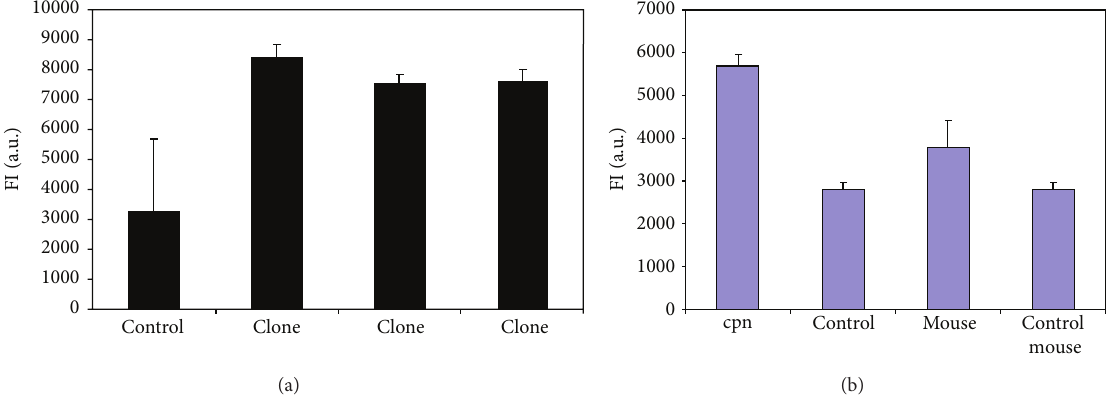
Figure 6: Measurement of SMase activity from lysates of JM109 transformed with recombinant pGEX-4T-3 by Amplex Red assay. Resorufin fluorescence FI a.u. (fluorescence intensity, arbitrary units) was measured. E. coli JM109 transformed with recombinant pGEX-4T-3 were induced with 0.5 mM IPTG. Three hours later, the cells were lysed as described in Section 2. Ten 10 𝜇 L of the lysate was used in the measurement done after 30 minutes of incubation at 37 ∘ C. (a) SMase activity of free different clones of CPn0300 was measured. (b) SMase activity of E. coli lysates expressing CPn0300 and C. muridarum TC 512 was measured. Controls express plain